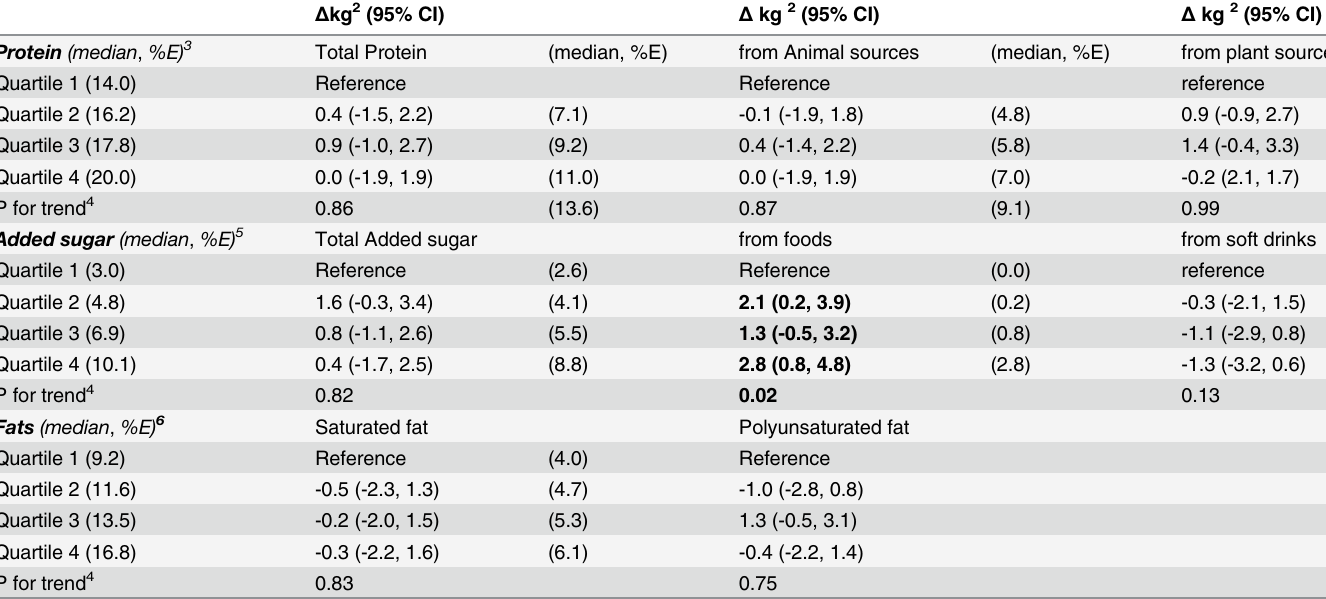
Table 4. Association 1 between intake of selected macronutrients at baseline and gestational weight gain (n = 366). Associations are explored for those macronutrients that were affected by the dietary intervention as presented in Table 2. Δ kg 2 (95%